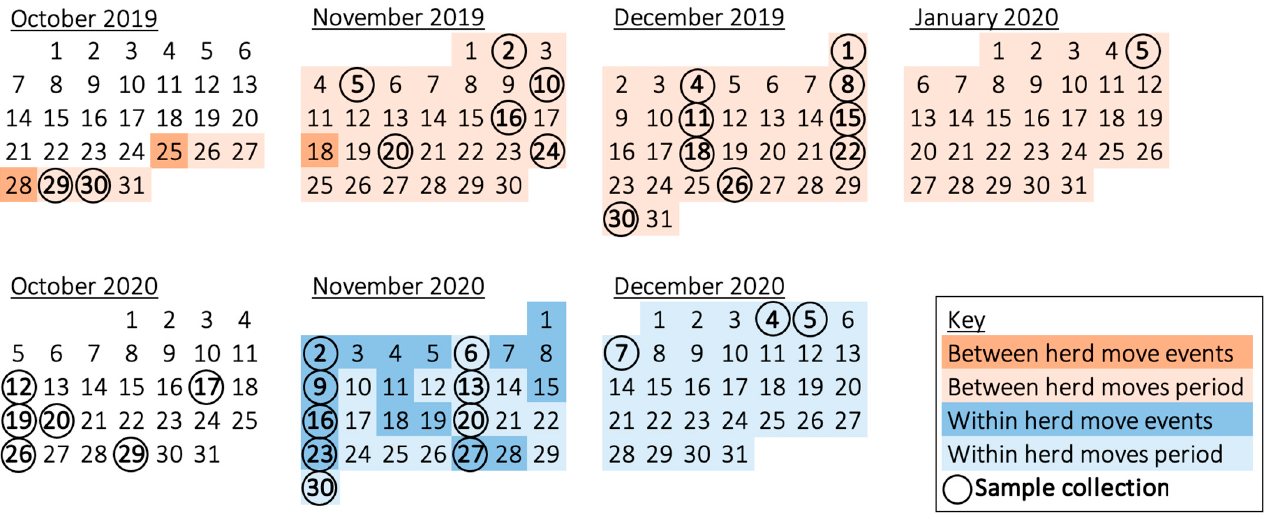
Figure 1. Calendar of the two virus screening periods, illustrating the dates of sample collection and management events. Circled dates describe sample collection from five elephants—except, in the case of consecutive dates (19–20 October 2020 and 4–5 December 2020), at which times the four cows were swabbed the first day and the bull was swabbed the second. Two bulls were moved away on 25 October 2019, a new bull moved into his respective enclosure on 28 October 2019, and tactile contact through a barrier was allowed with the cows after 18 November 2019; hence, samples collected from 30 October 2019 to 5 January 2020 were assigned as the ‘between herd moves’ period. Direct mingling for breeding took place throughout November 2020; thus, samples from 2 November 2020 to 7 December 2020 were designated as the ‘within herd moves’ period. The control period of social stability occurred throughout October 2020. ‘Social change’ represents the between and within herd moves management